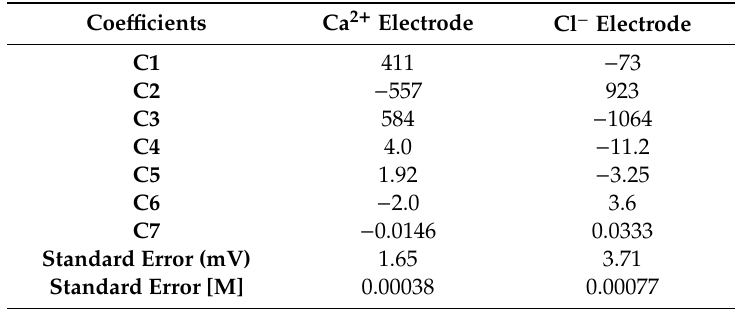
Table 5. Linear Regression Parameters and Terms for Calcium and Chloride ISE.